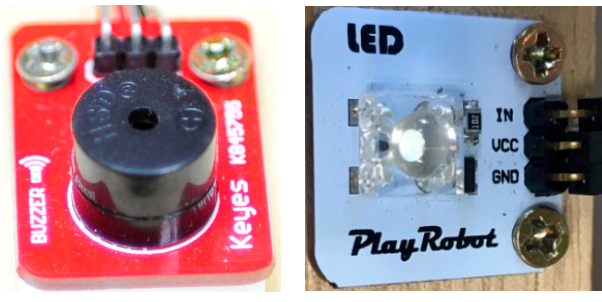
Figure 9. Sound and light alarm.